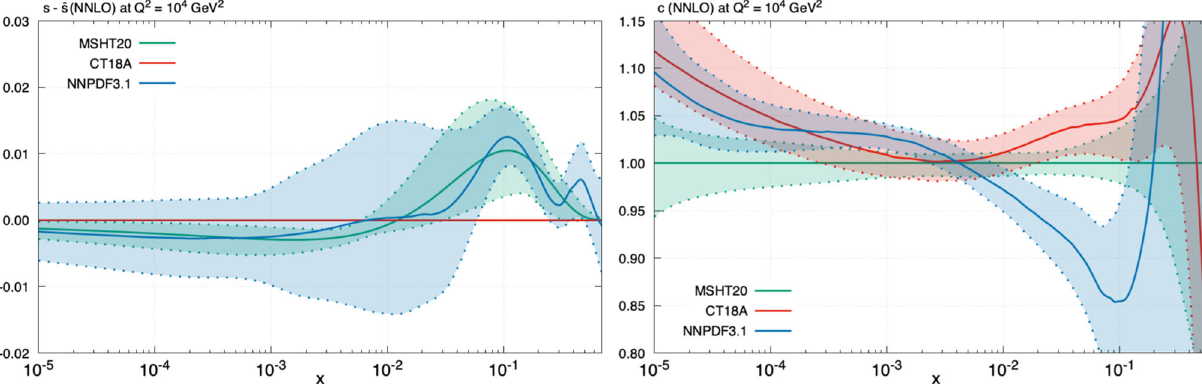
Fig. 95 Comparison of the MSHT20 NNLO s − s and charm PDFs at Q 2 = 10 4 GeV 2 with other representative PDF sets. These correspond to α ( M 2 ) = 0 . 118 in all cases. The charm case is presented as a ratio to the MSHT set while for the s − s the PDF values are S Z